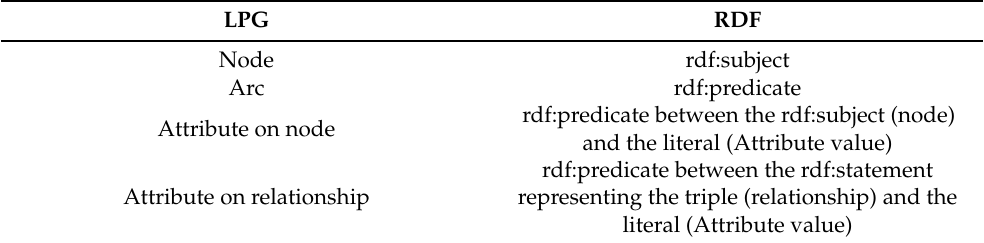
Table 7. Translations from data in the LPG graph to data in the SW